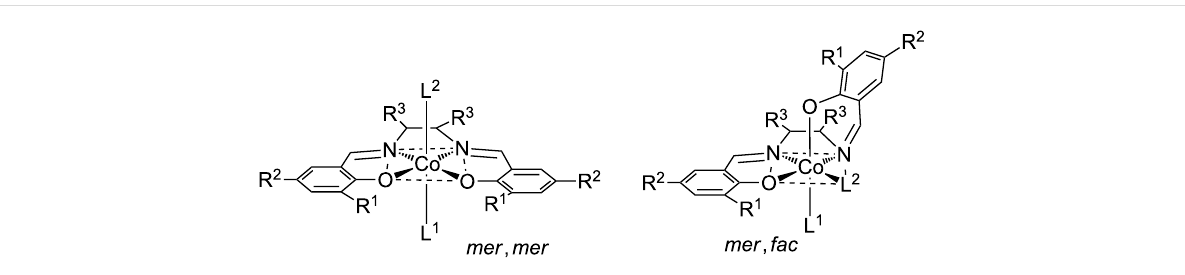
Figure 3: The two most relevant configurations of [(2-hydroxyethoxy)Co III (salen)(L)] complexes. The left-hand model shows a mer , mer -configuration, while the right-hand models shows a mer , fac -configuration of the salen ligand.